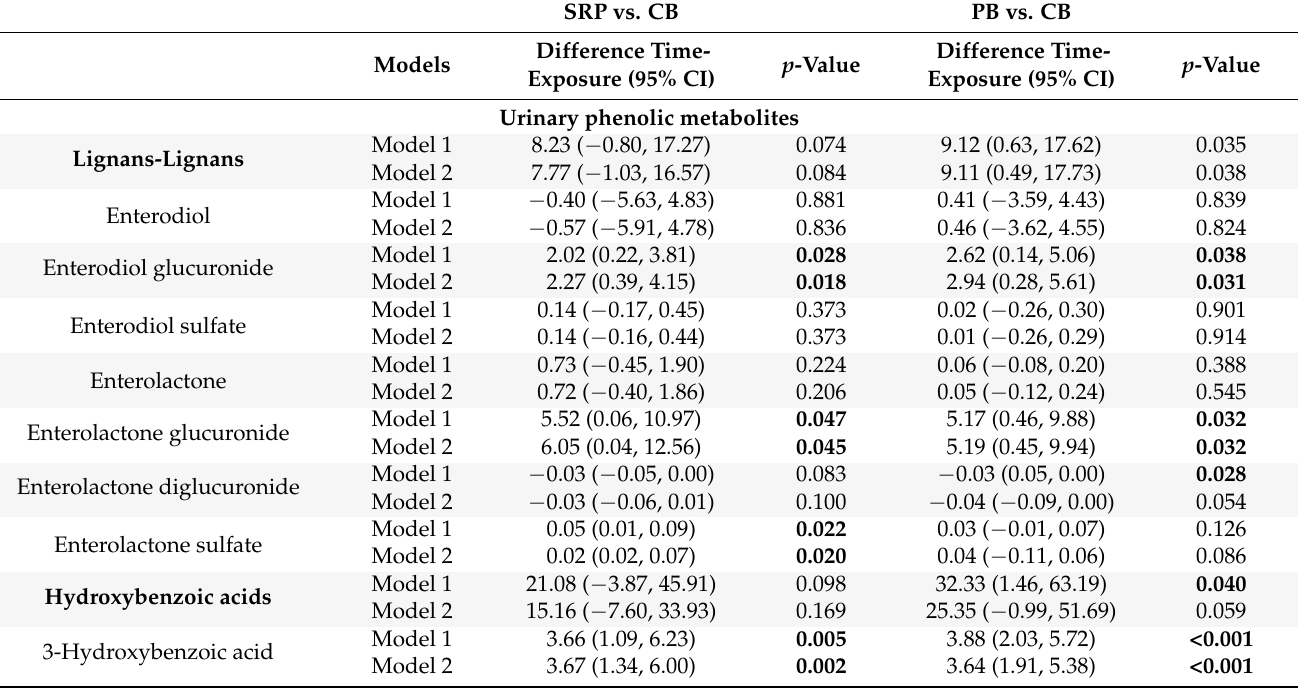
Table A1. Intervention effect on the levels of urinary phenolic metabolites at 6 months. SRP vs.